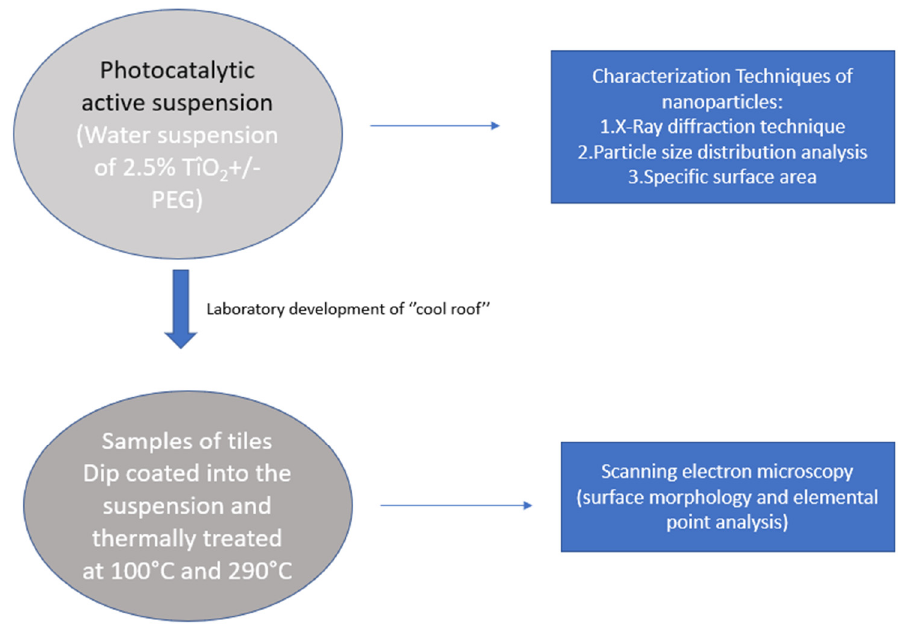
Figure 1. Representation of the experimental methodology